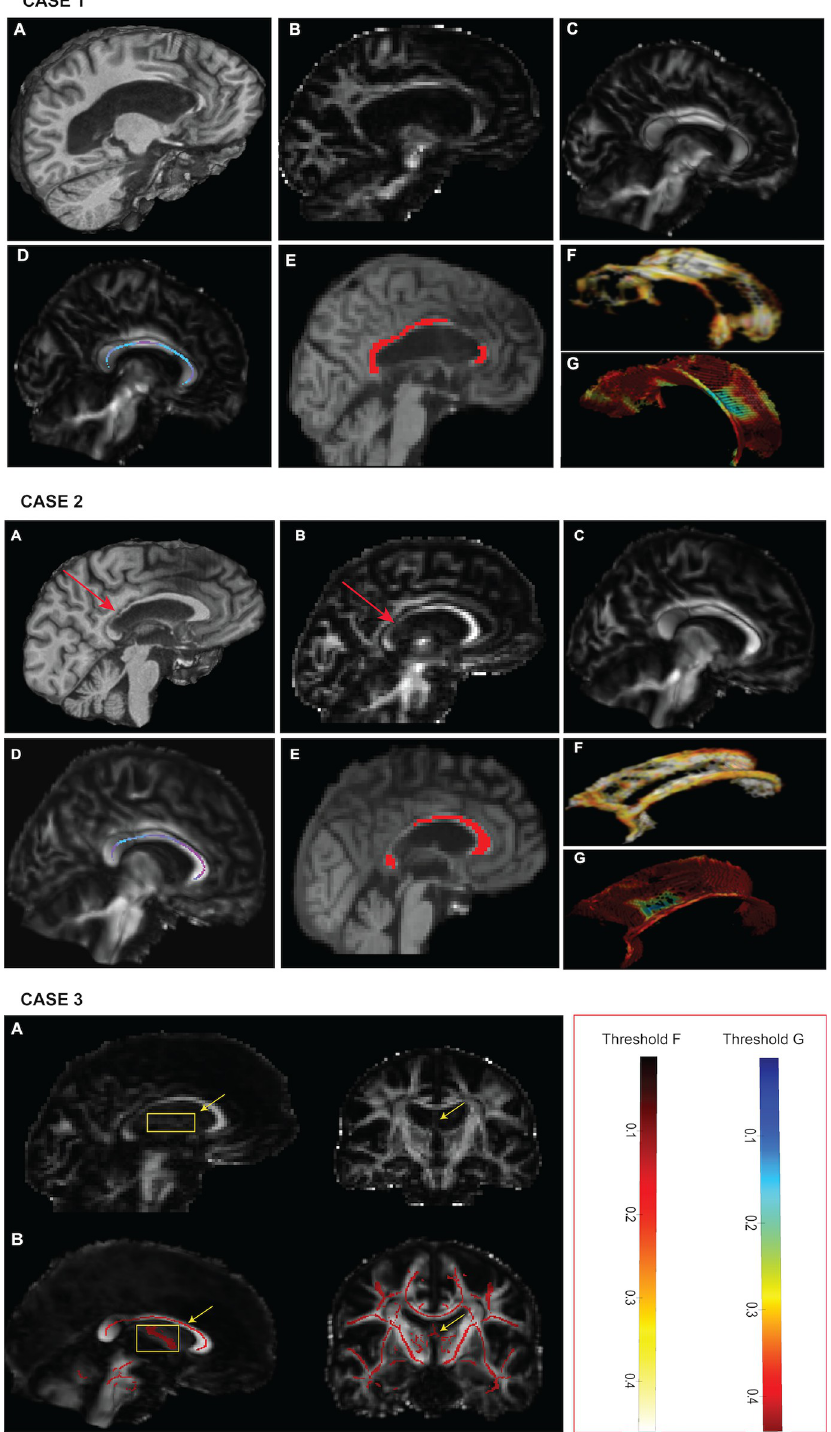
Fig 10. Visual representation of case studies of patients with severe TBI. Cases 1 and 2 show the segmentation of the corpus callosum, and case 3 illustrates the robustness of the pipeline when a signal is not detected on the DWI image. A) native T1 image to illustrate structural abnormality before registration to the diffusion image, B) FA map in native diffusion space, C) FA map following registration to a higher resolution standard template through non-linear alignment, D) TBSS segmentation of corpus callosum and heatmap of FA values, E) SSDS segmentation of the tract,